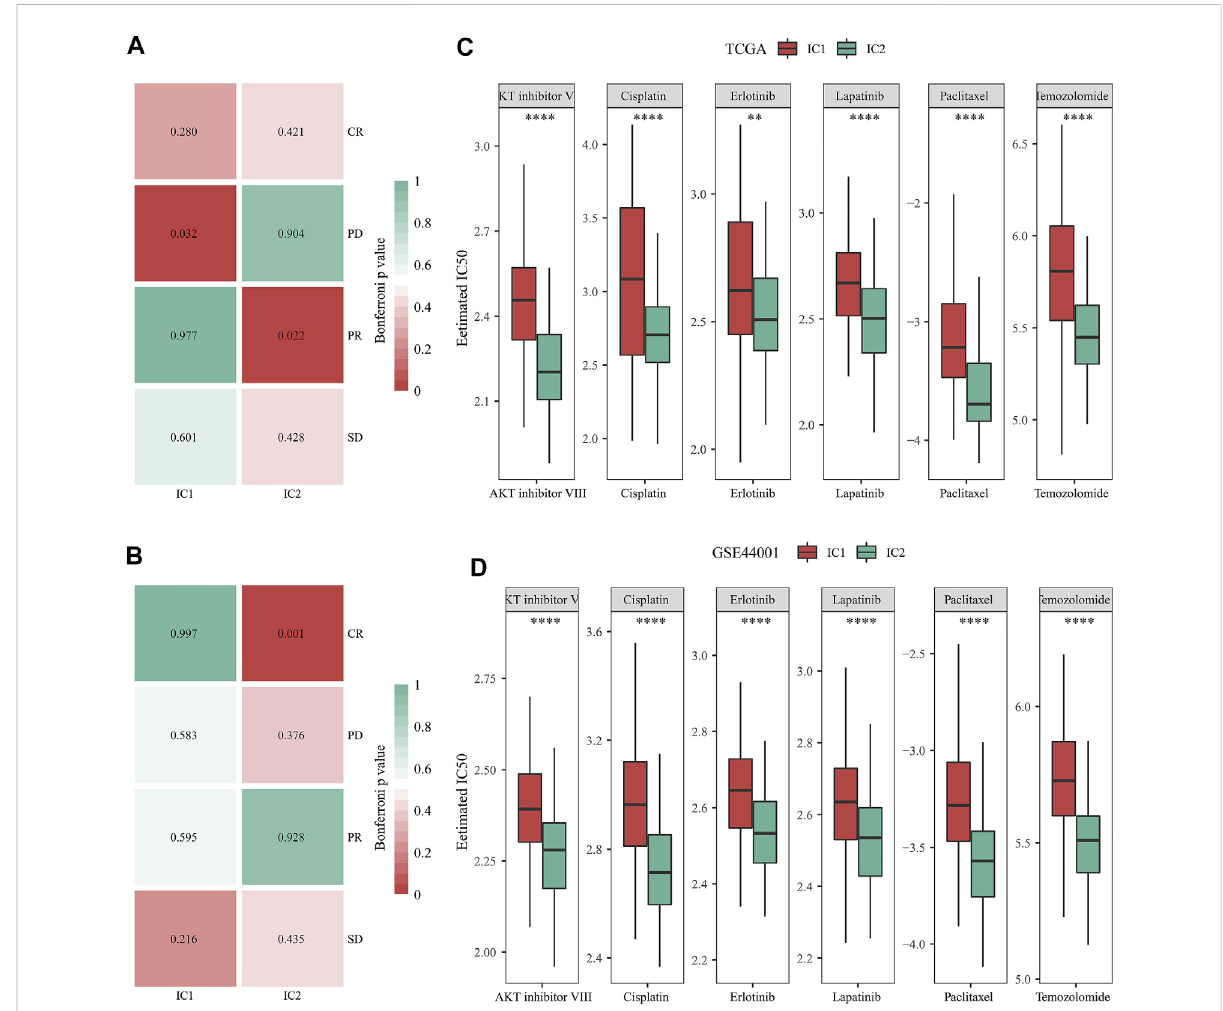
FIGURE 7 Immune subtypes with distinct immuno-, targeted, and chemotherapeutic responses. (A,B) Submap for comparing the expression pro fi ling of